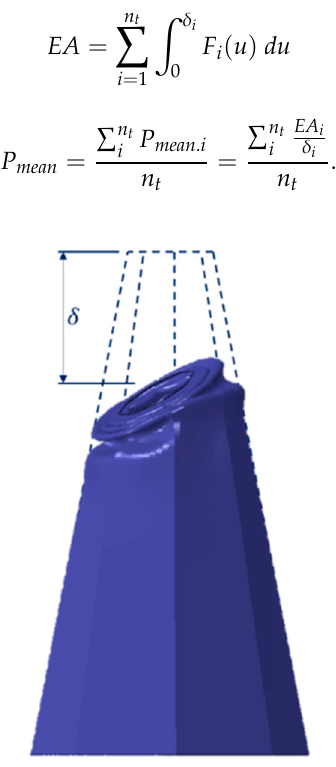
Figure 2. Mild steel deformed tube representation.